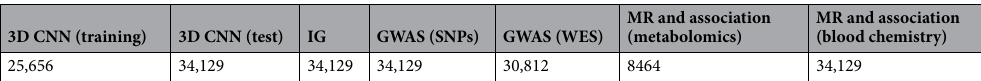
Table 1. The number of samples in each stage of the